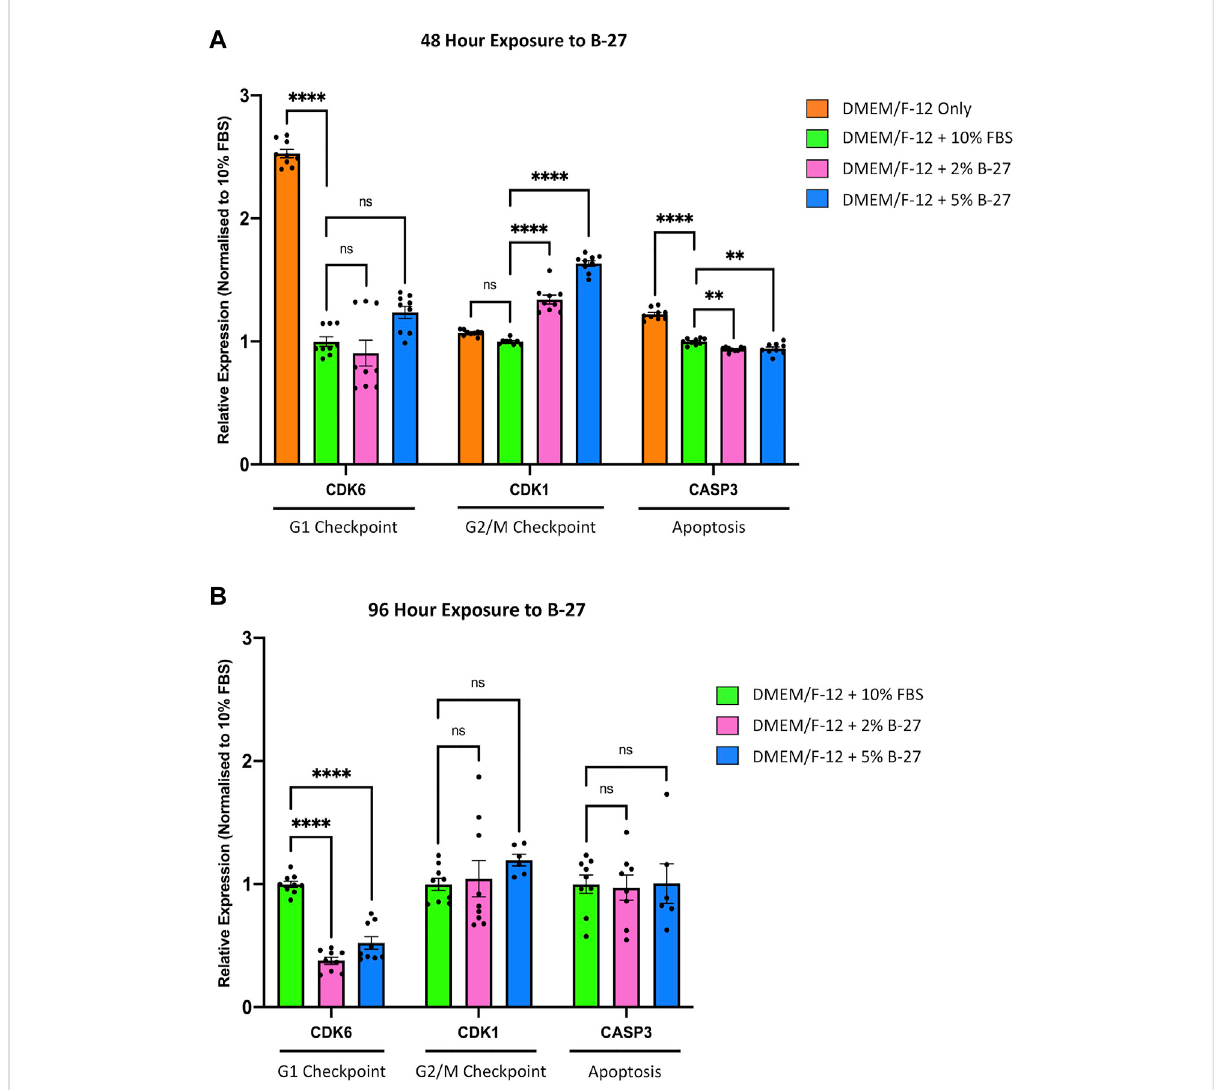
FIGURE 4 Longer term B-27 exposure leads to SH-SY5Y cell cycle arrest. SH-SY5Y cells were cultured in DMEM/F-12 only, or DMEM/F-12 supplemented with either 10% FBS, 2% B-27 or 5% B-27 for (A) 48 h or (B) 96 h. qRT-PCR was performed to measure mRNA expression of cell cycle markers CDK6 and CDK1 , and apoptosis marker CASP3 . Relative expression of CDK1 , CDK6 , and CASP3 (standardized to GAPDH and POLR2A ) normalized to the DMEM/F-12 + 10% FBS culture conditions. Data presented as mean ± SEM. N = 3 independent biological samples with two to three technical replicates each. Statistical signi fi cance against the DMEM/F-12 + 10% FBS condition was determined using ordinary one-way ANOVA and Tukey ’ s multiple comparison tests in GraphPad Prism version 9.0.0 for Mac, GraphPad Software, San Diego, California, United States,